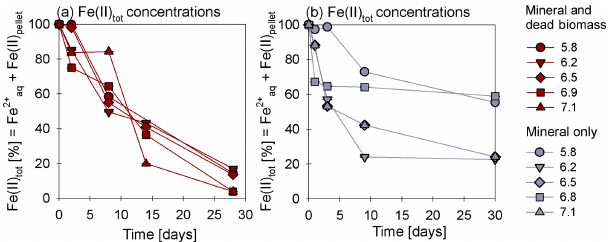
Figure 2. Oxidation of total Fe(II) over time given (reported as a percentage of the initial concentration) in the mineral and dead biomass amended (red) and the mineral-only set-up (grey), tested at different pH levels. The standard error calculated from biological replicates ( n = 9) is represented by the error bars.